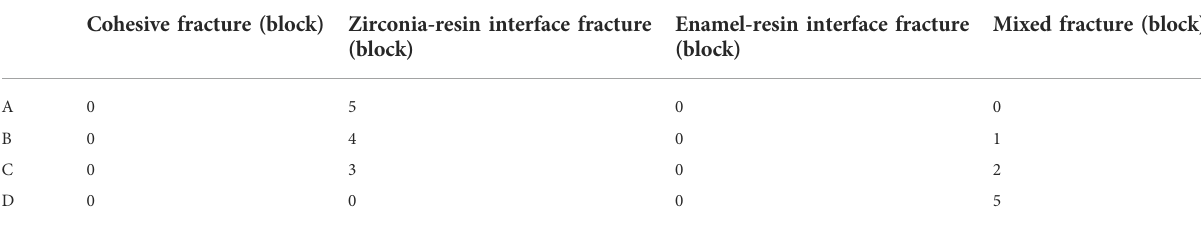
TABLE 1 Fracture modes of zirconia specimens. Group Fracture